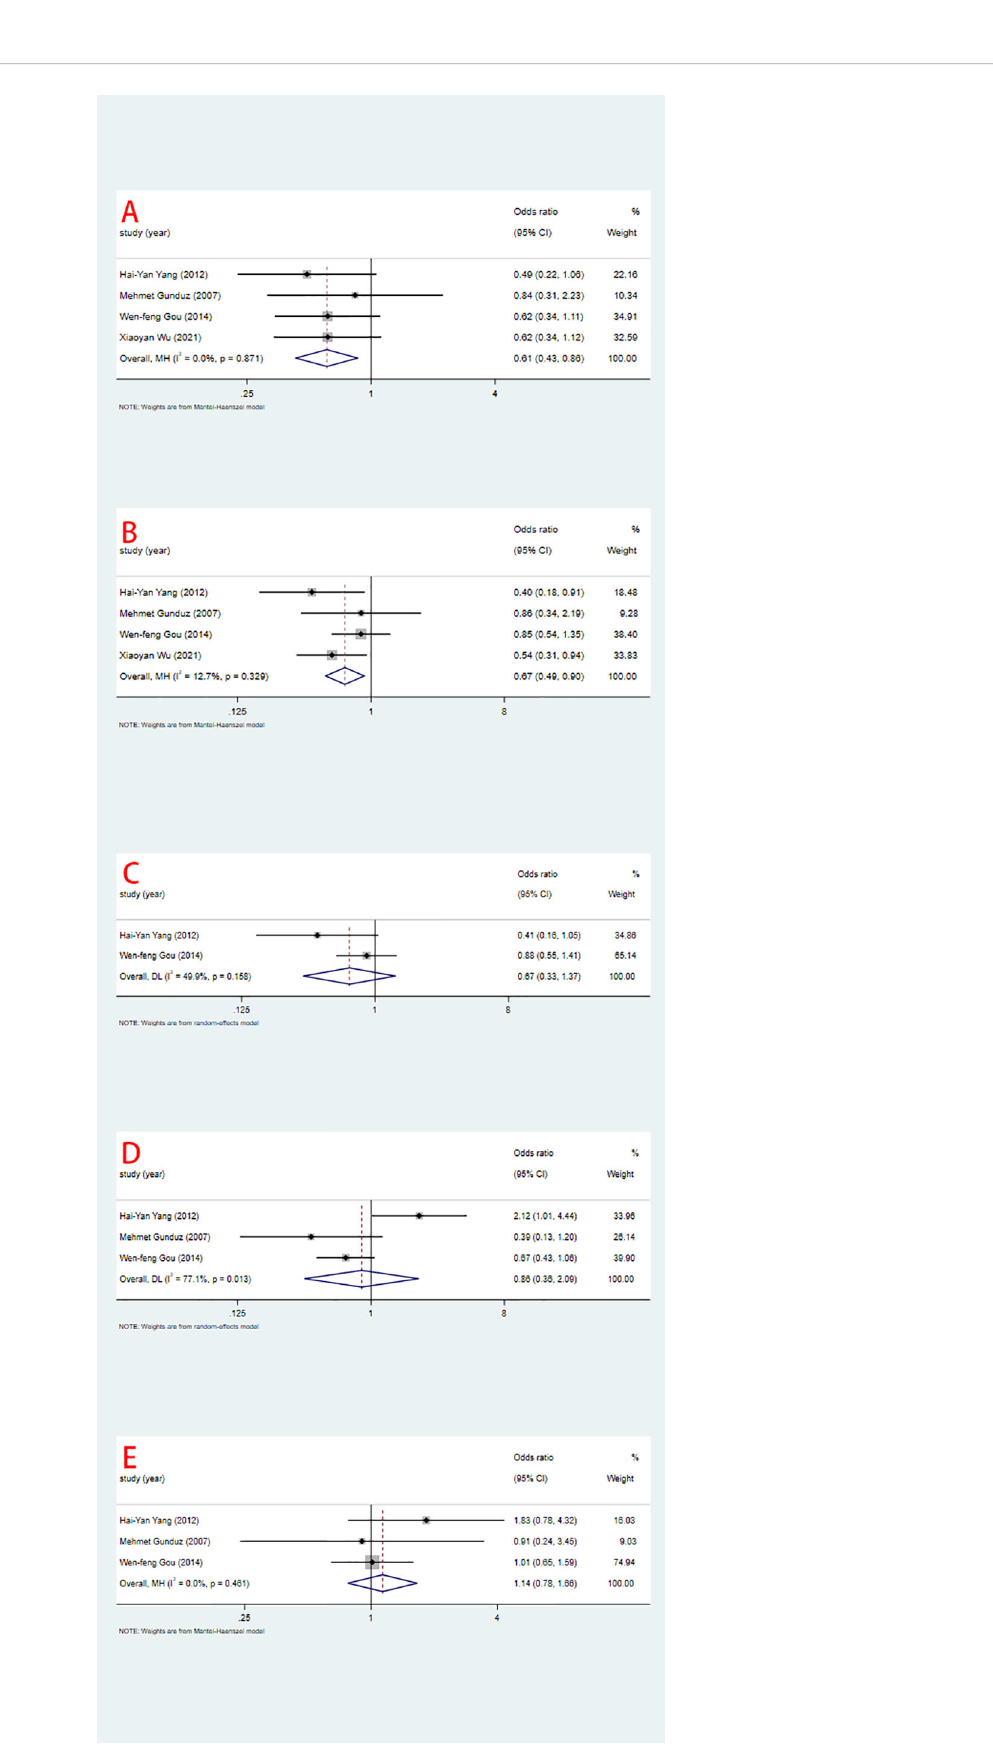
FIGURE 3 Relationship between ING3 expression and TNM stage (A) , lymph node metastasis (B) , tumor size (C) , tumor differentiation (D) and gender (E)